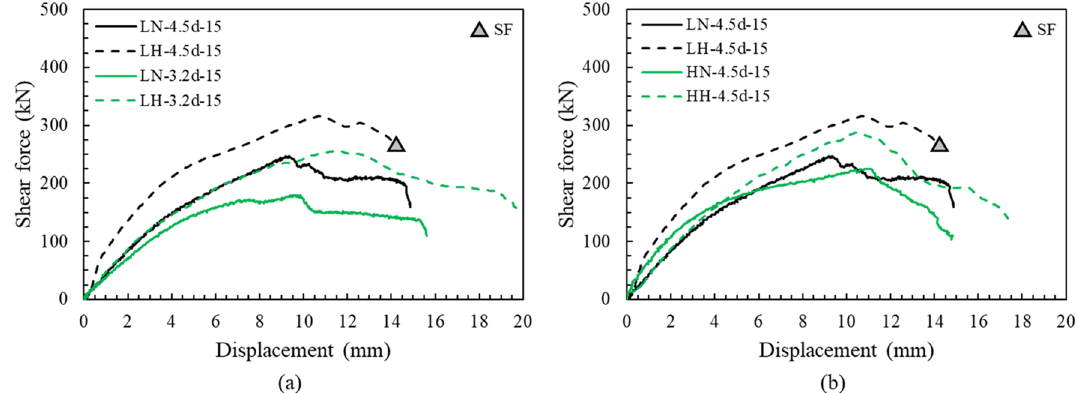
Figure 10. Load–displacement curve, compressive strength of concrete: ( a ) edge distance, ( b ) pedestal height.